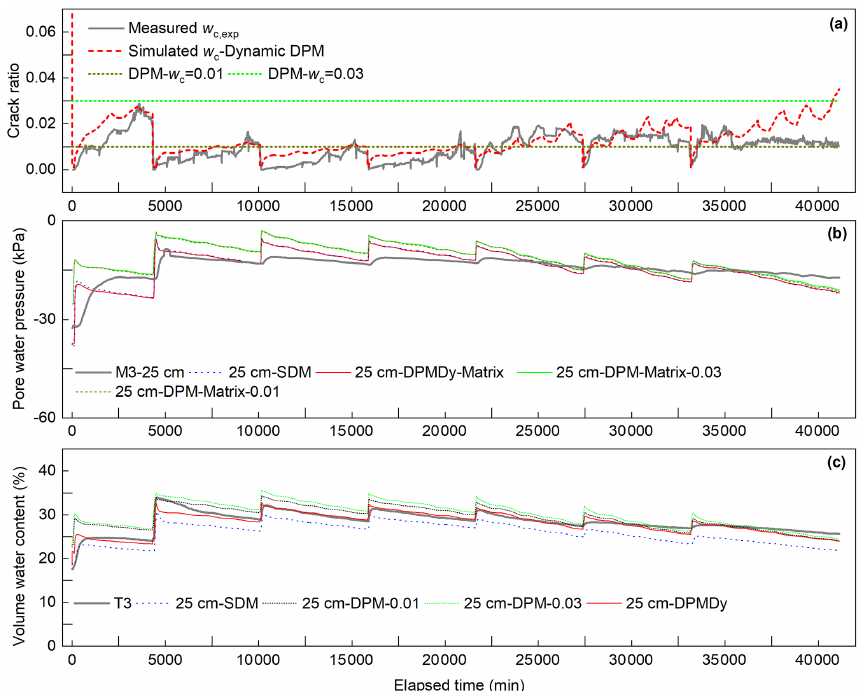
Figure 15. Temporal evolution of the measured and simulated crack ratio, matric suction and volumetric water content. (a) Measured and simulated crack ratio on soil surface, (b) measured and simulated matric suction at 25cm depth and (c) measured and simulated total water content at 25cm depth.